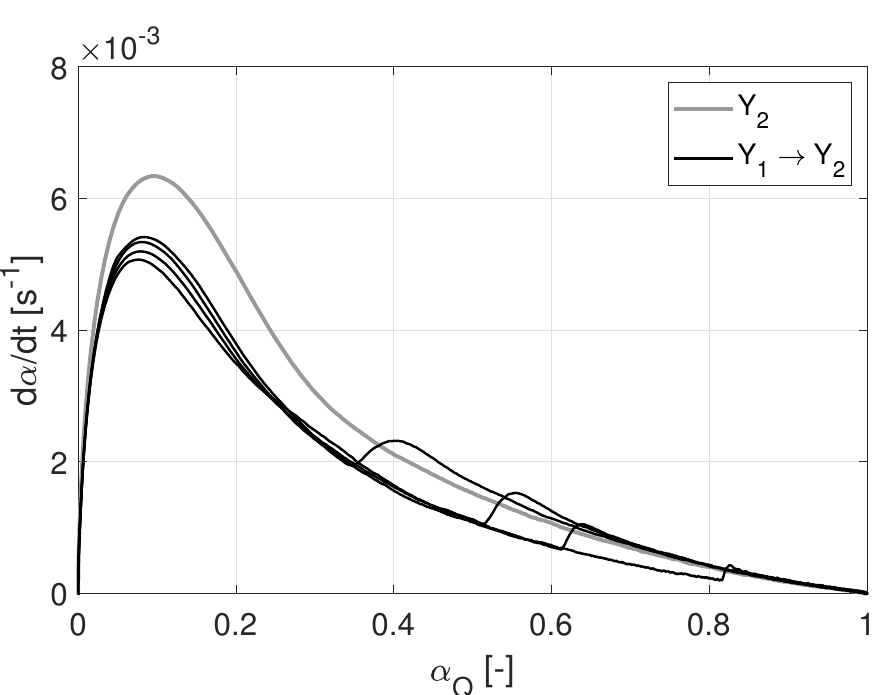
Figure 10. The conversion rate d α / dt as function of α Q for the f ( α ) -test. Y 2 shows the conversion rate at T hyd = 40 ◦ C and P wv , hyd = 12 mbar without jumps. Y 1 starts at T hyd = 40 ◦ C and 10 mbar, and